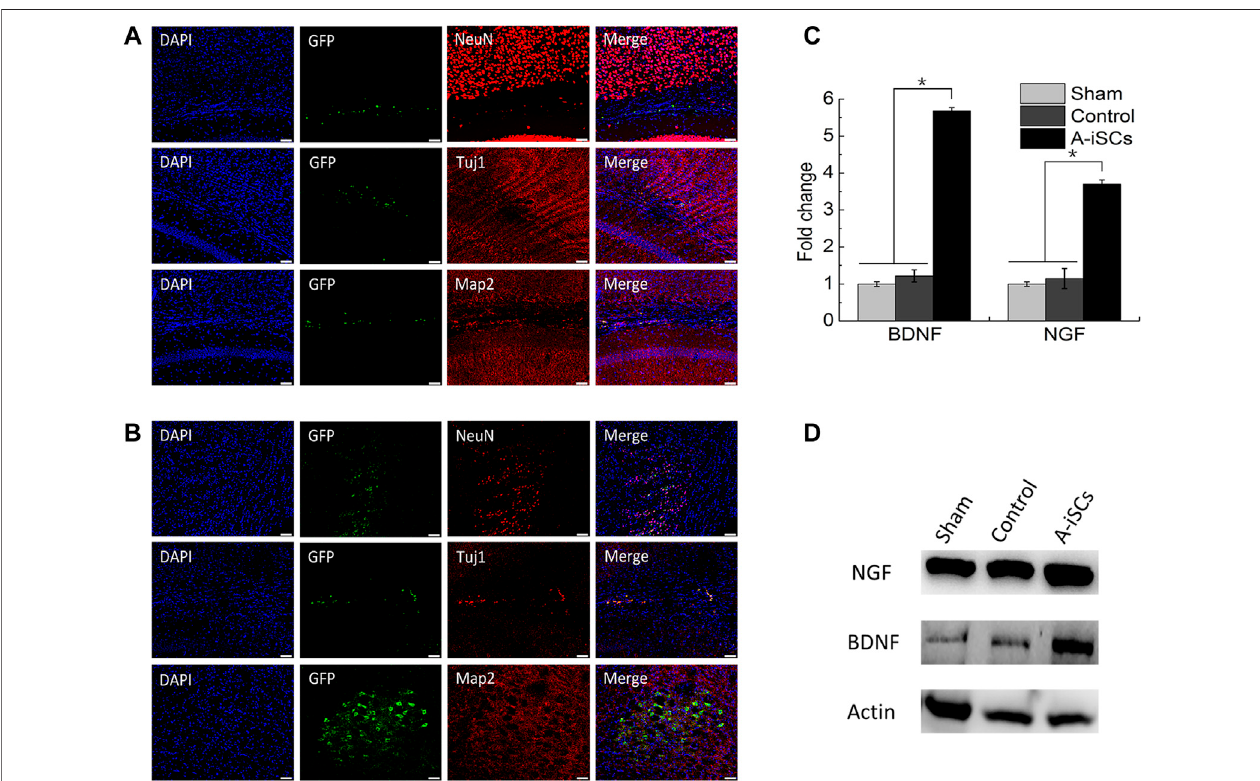
FIGURE5| ImmunostainingofNeuN,Tuj1,andMap2inA-iSCstransplantedintothebrainsofnormalmice (A) andMCAOmice (B) .Scalebarsof (A,B) :50 μ m. (C) RT-PCRforBDNFandNGFoftheMCAOmicethroughA-iSCstransplantationincomparisontoshamandcontrolgroupsat8 weeks.* p < 0.05. (D) Westernblottingfor BDNF and NGF of the MCAO mice through A-iSCs transplantation in comparison to sham and control at 8 weeks.